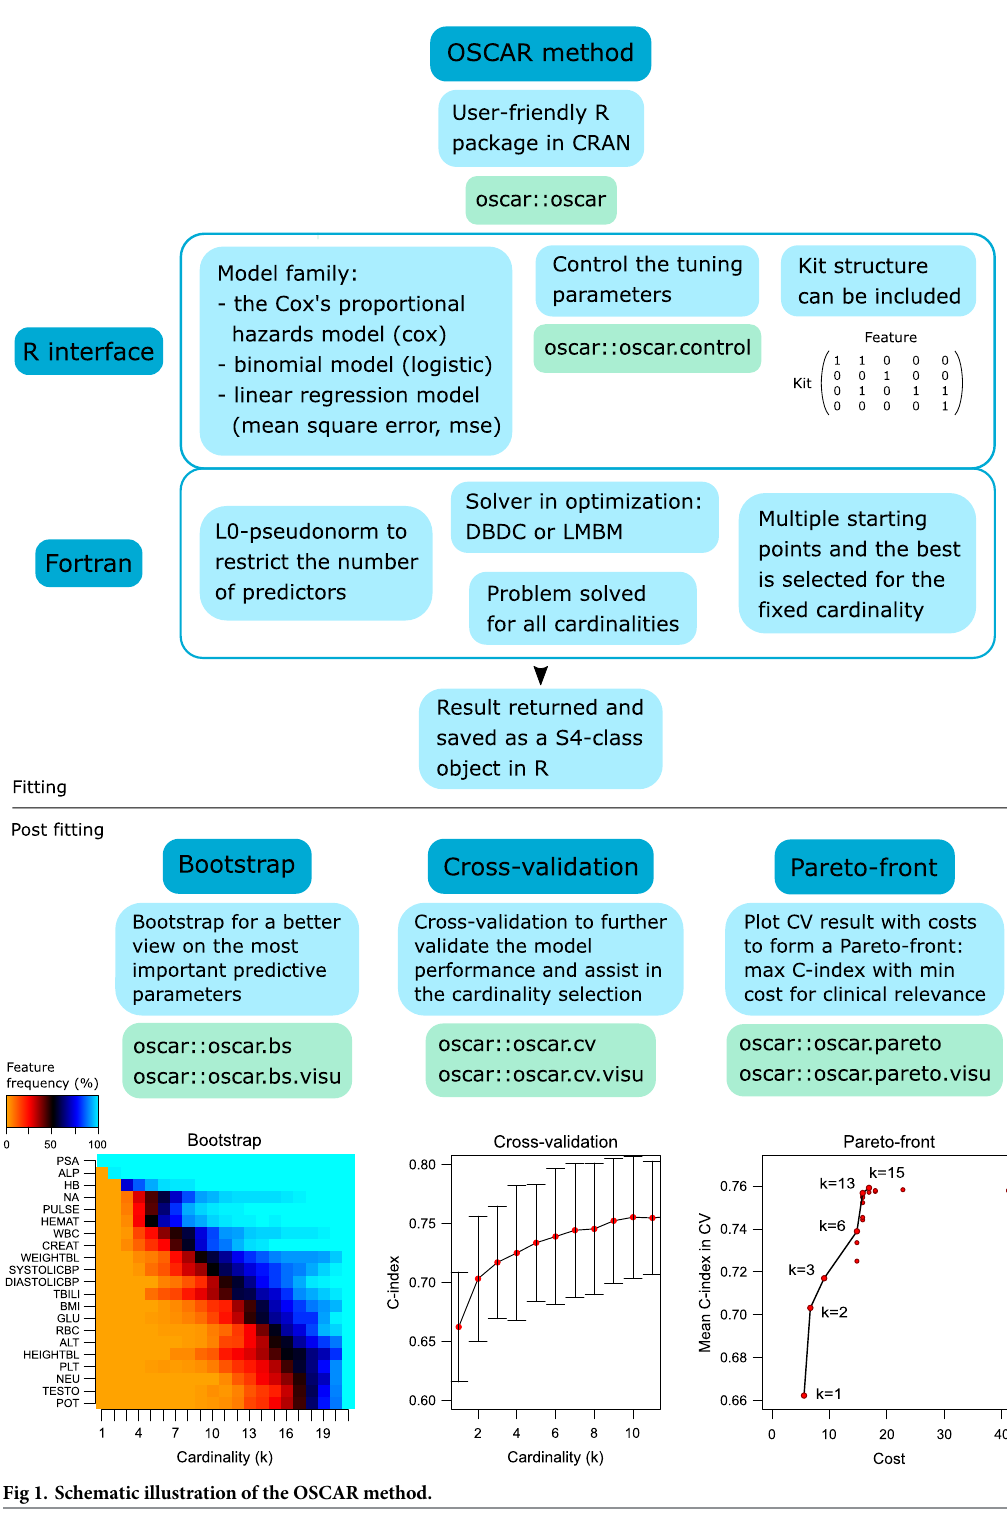
Fig 1. Schematic illustration of the OSCAR method.